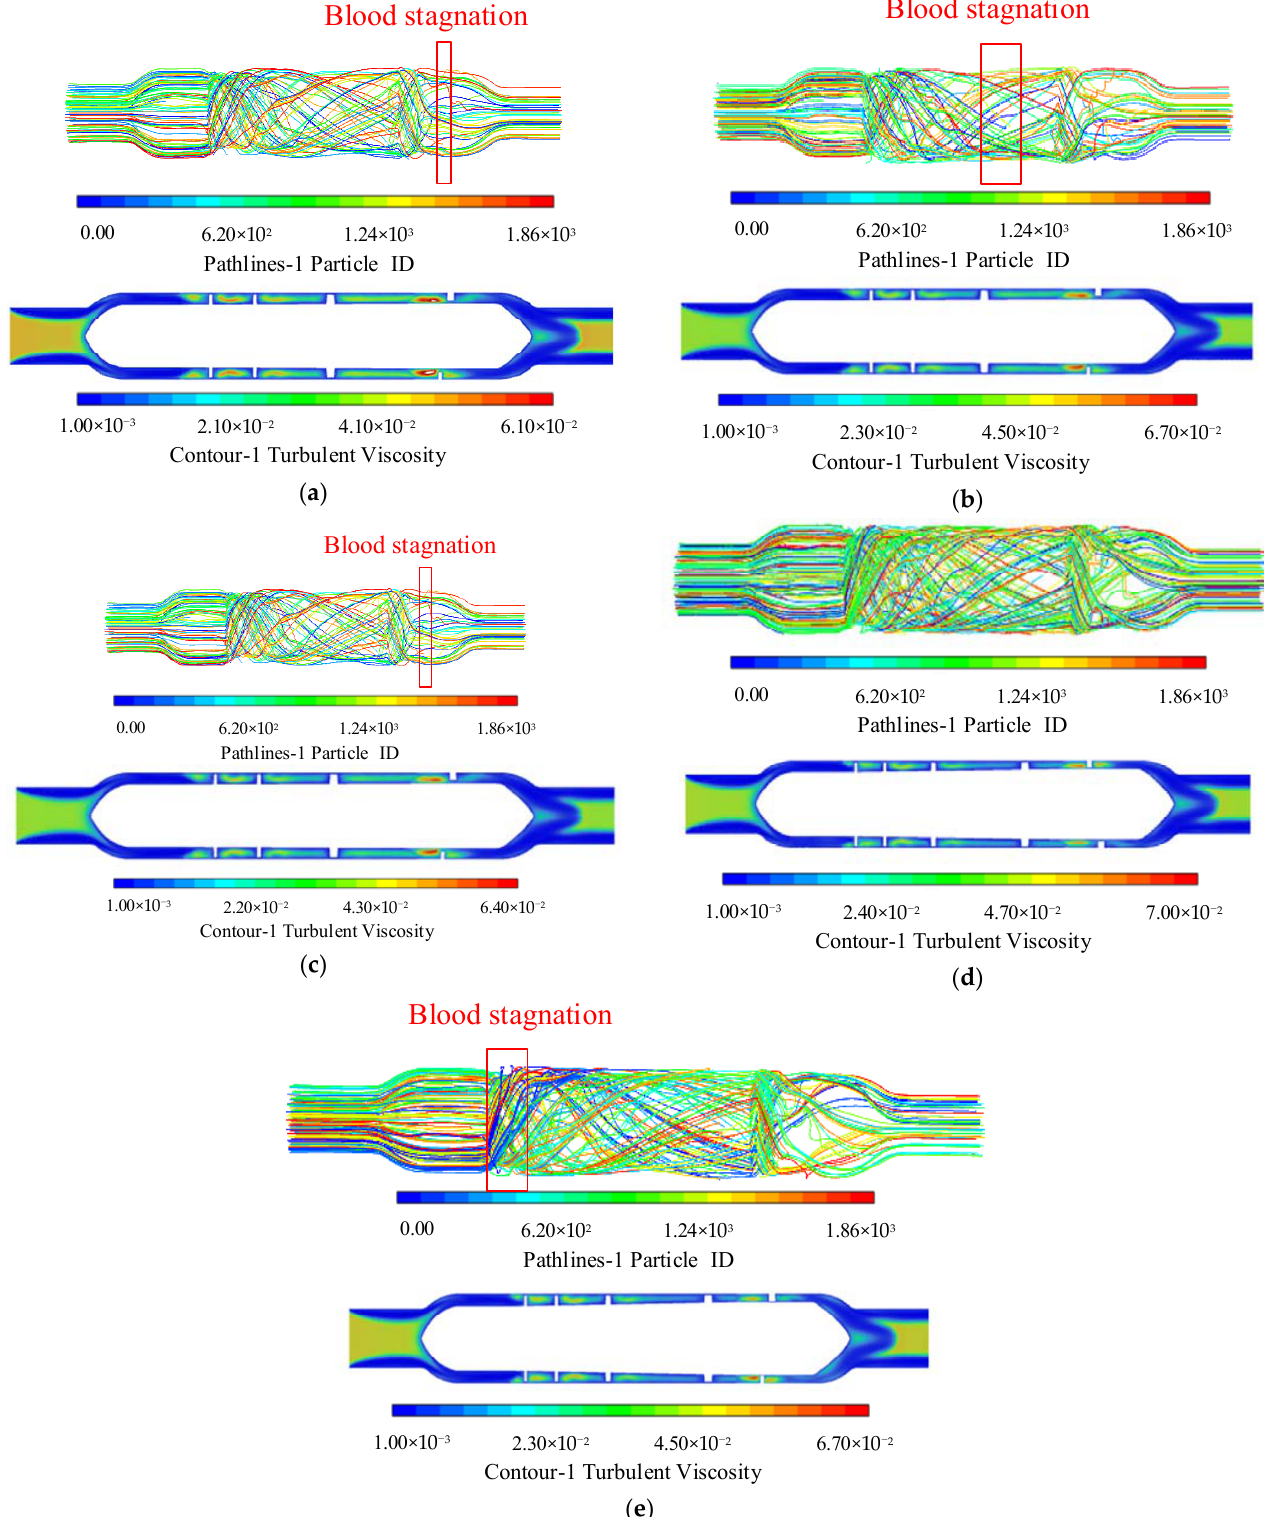
Figure 8. Streamline distribution and turbulent viscosity of the blood pump at taper angles of ( a ) 0°, ( b ) 0.25°, ( c ) 0.5°, ( d ) 0.75°, and ( e ) 1°.